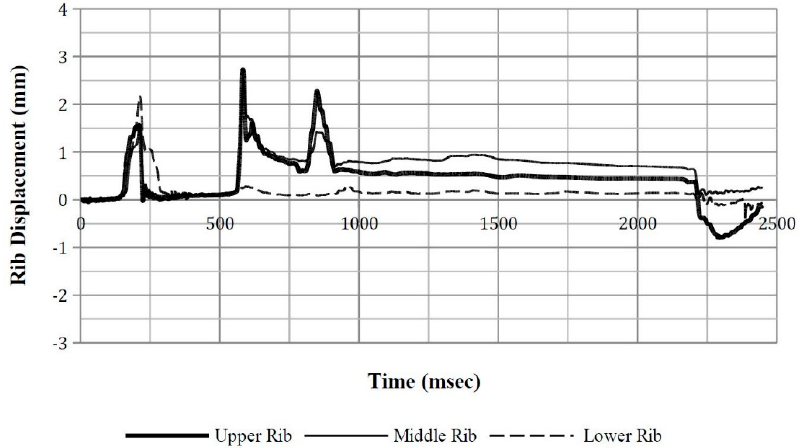
Figure A8. ATD Position 5 rib displacement.